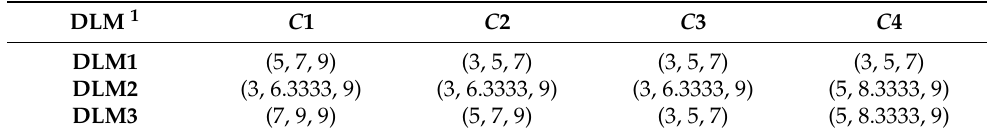
Table 6. Combined decision matrix for three distance learning course assessment according to the military students’ opinion on the quality of these courses.